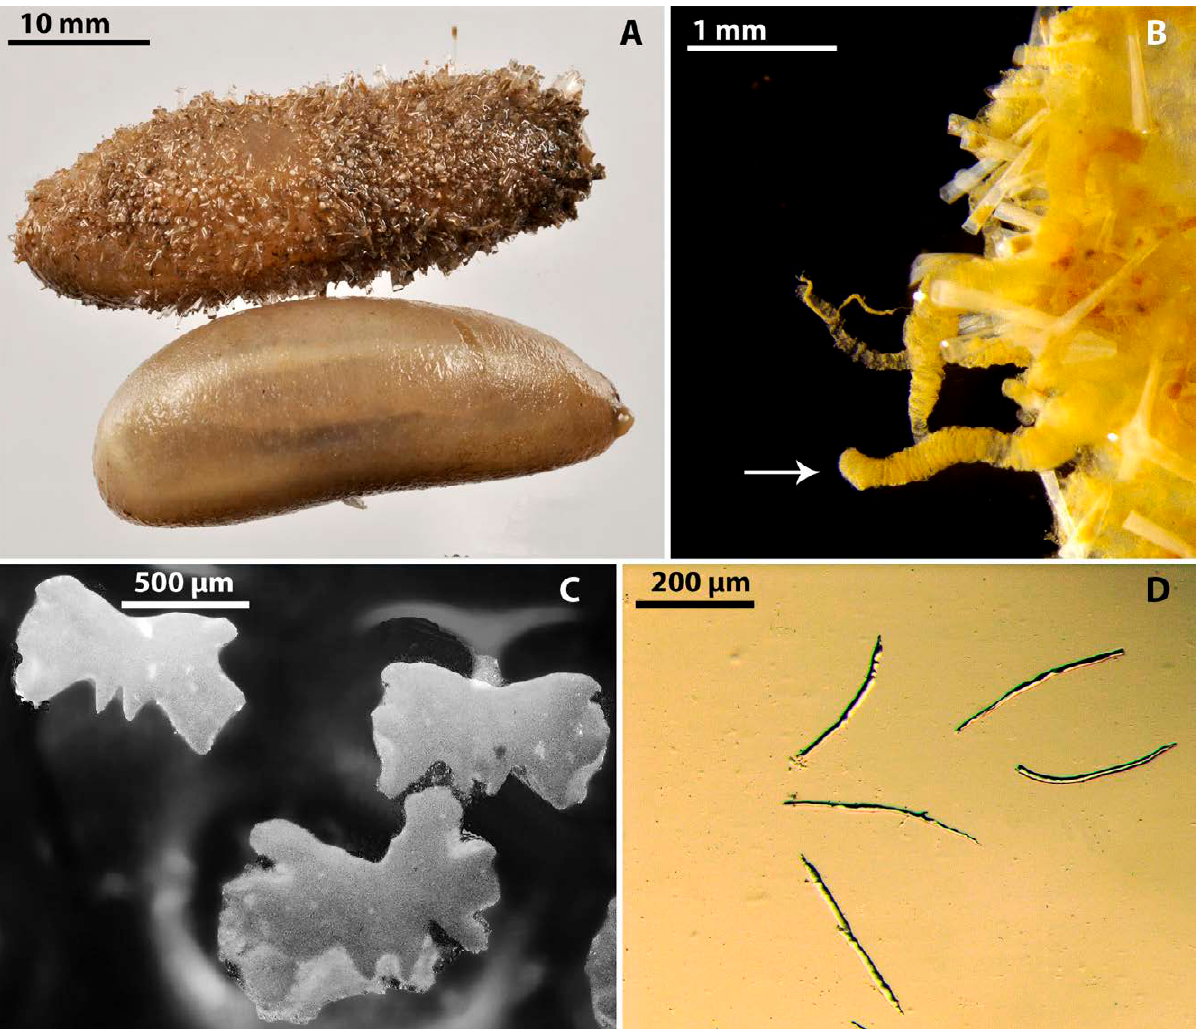
Fig. 8. – Pseudostichopus occultatus characteristics . A, general view, with and without pteropod cover (Photo from A. Bozzano); B, tube feet detail and encrusted pteropods; C, detached pieces of the calcareous ring; D, irregular spiny ossicles from respiratory trees and